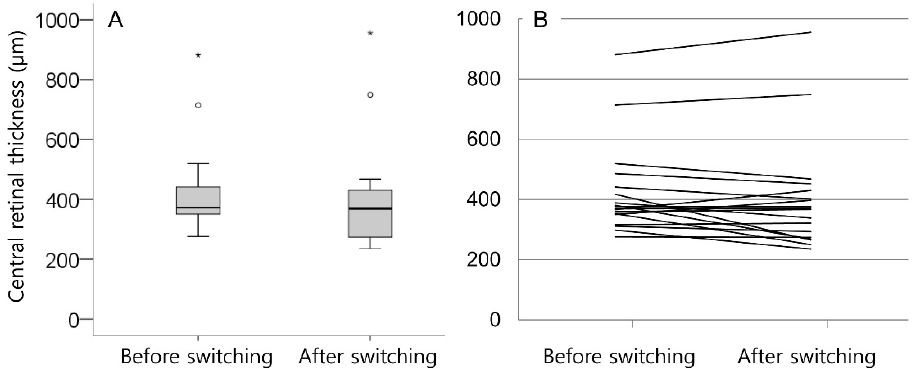
Figure 1. Box plot ( A ) and line graph ( B ) show distribution of central retinal thickness before and after switching to ranibizumab. Line graph ( B ) shows changes in central retinal thickness in all 18 patients separately. Circles and asterisks ( A ) indicate outliers.